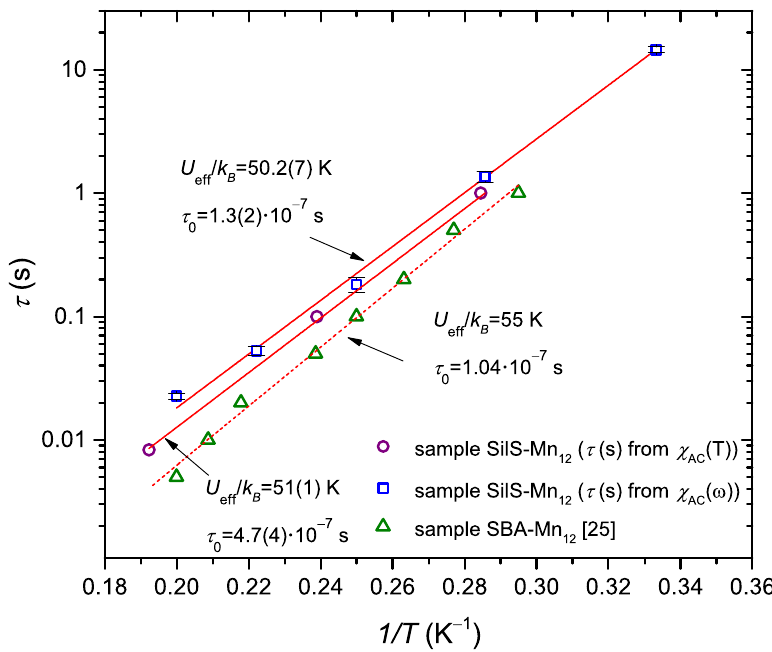
Figure 4. Relaxation times in function of inverse temperature for sample SilS-Mn 12 in comparison to the SBA-Mn 12 sample (solid lines stand for the best fit to the Arrhenius function (2) for each measure- ment).